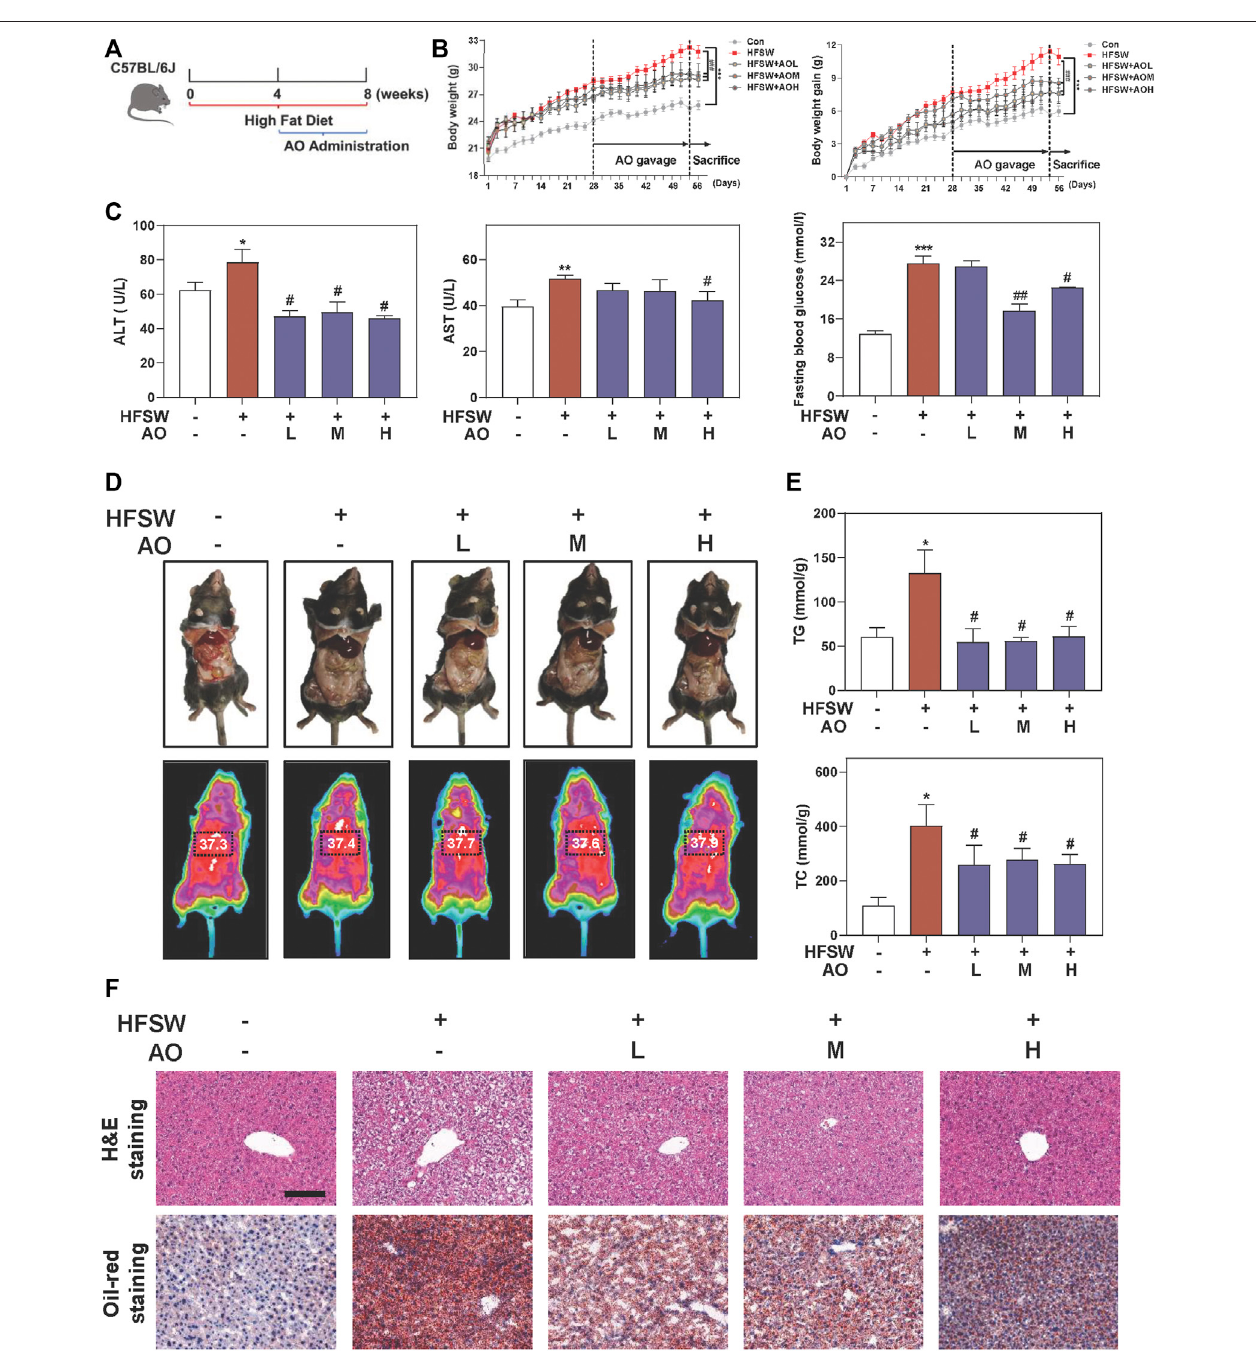
FIGURE 1 | AO ameliorates hepatic steatosis in HFSW-fed mice. Mice were fed with chow diet or HFSW diet for 8 weeks and administered with different dosages (5,10,and15 mg/kg)ofAObygavagefromWeek5 (A) Schematicdiagramof invivo experimentaldesign (B) BodyweightandBodyweightgain (C) LevelsofserumALT and AST and fasting blood glucose (D) Representative images of epididymal fat and thoracoabdominal temperature (E) Hepatic TG and TC levels (F) Representative imagesofH&EandoilredOstaining.Scalebar (cid:1) 100 μ m.Statisticalsigni fi cance:* p < 0.05,** p < 0.01,*** p < 0.001,comparedwithcontrolgroup; # p < 0.05, ## p < 0.01, compared with HFSW group (n (cid:1)